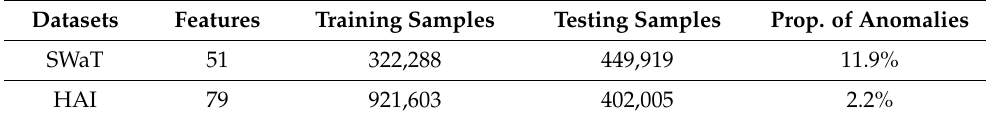
Table 1. Statistics of evaluation